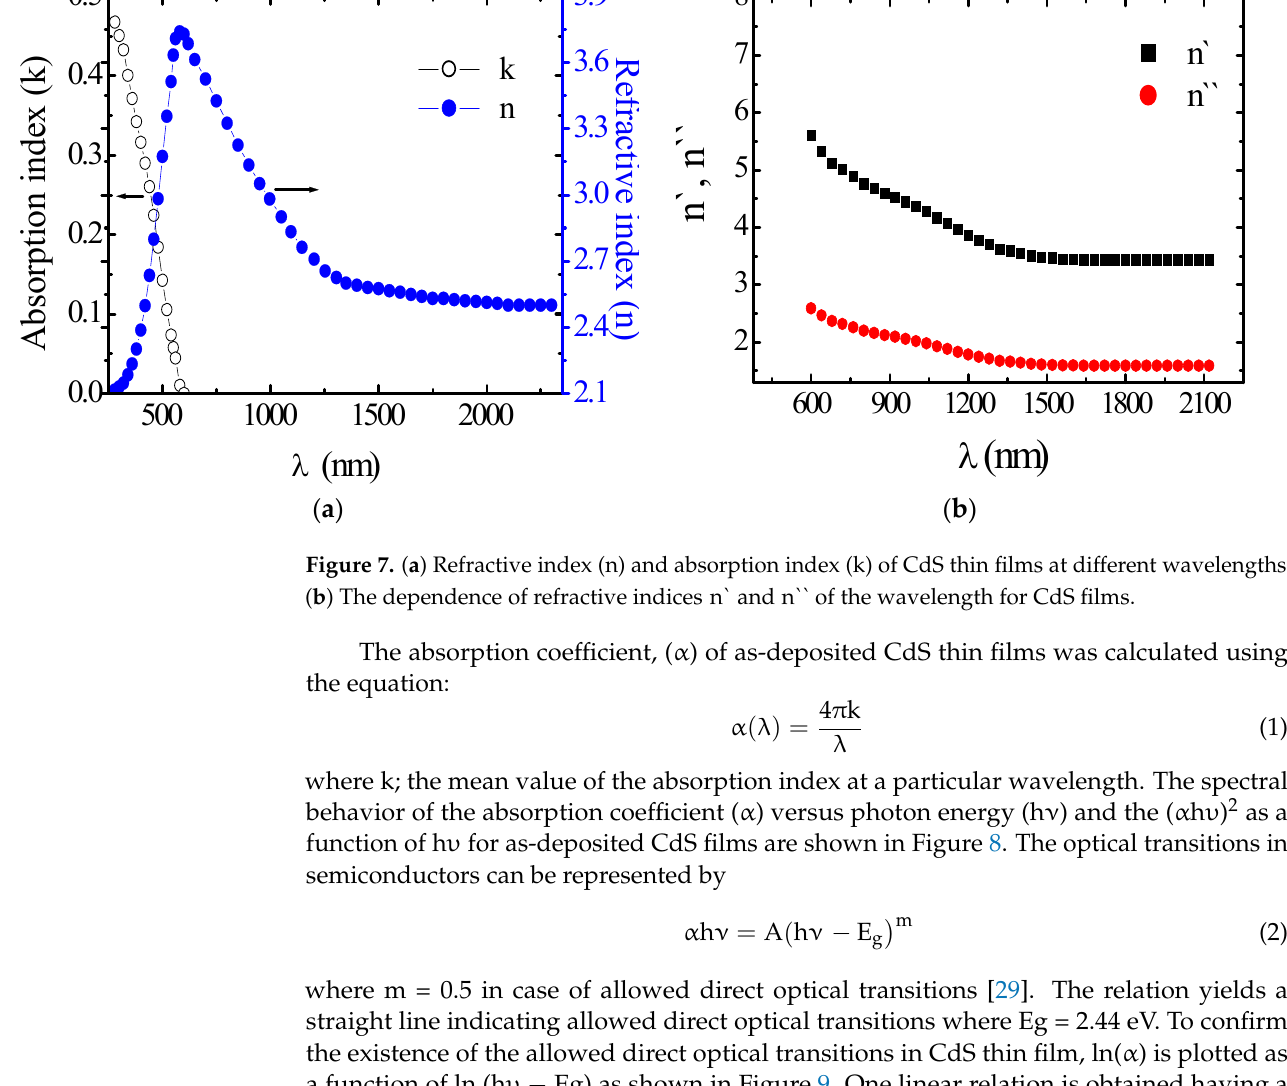
Figure 8. The relation between ( α h ν ) 2 and photon energy (h ν ) for CdS films.